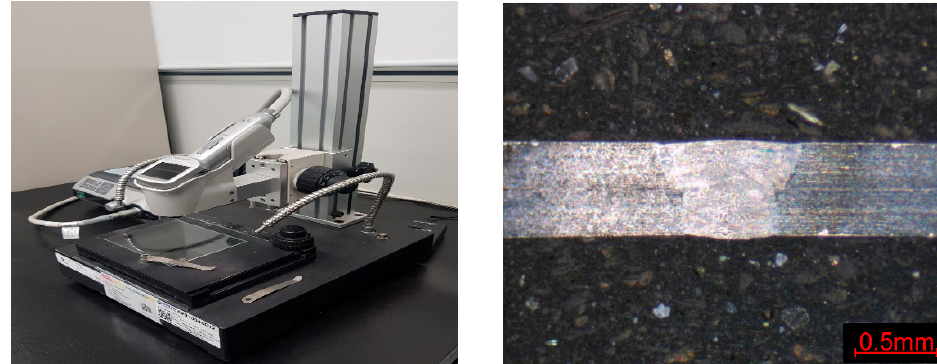
Figure 5. Optical microscope equipment and cross-section of a sample.